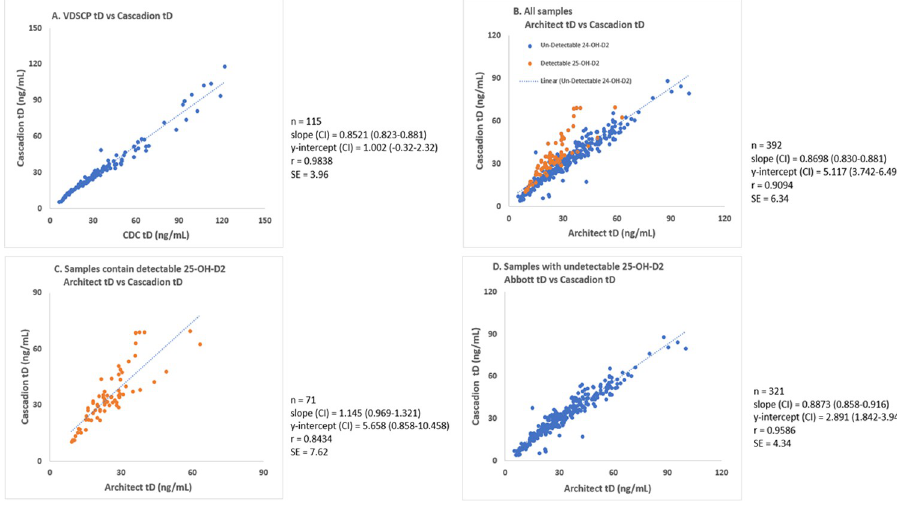
Fig 1. Linear plots and regression parameters. Correlation of Cascadion tD results to A) VDSCP tD B) Architect tD of all patient samples C) Architect tD of samples contain detectable 25-OH-D2 and D) Architect tD of samples with undetectable